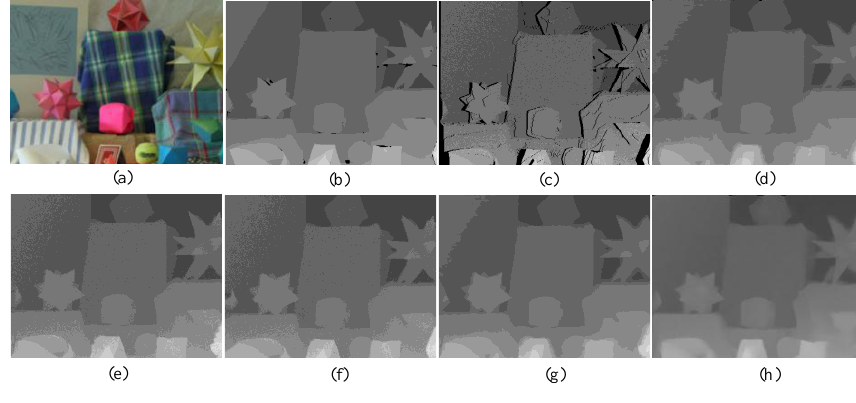
Figure 19. Results for Moebius from the Middlebury database: ( a ) Color image; ( b